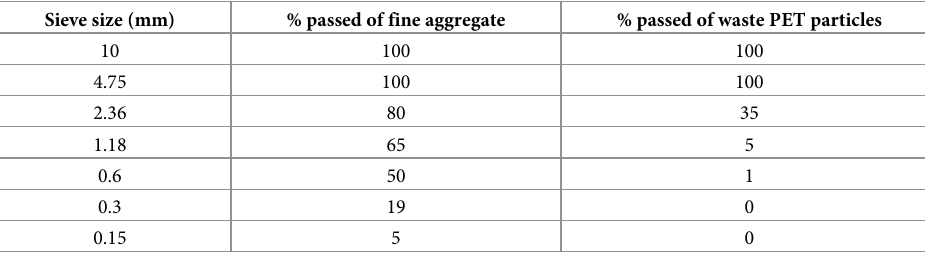
Table 5. Sieve analysis of PET and fine